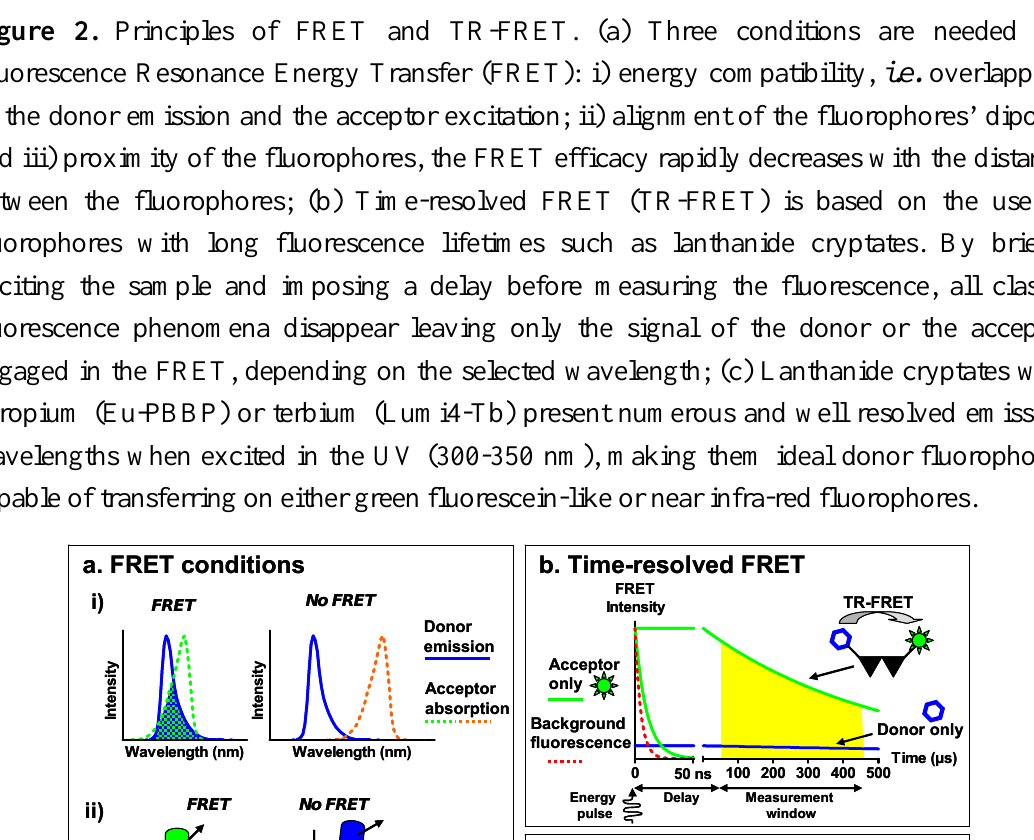
Figure 2. Principles of FRET and TR-FRET. (a) Three conditions are needed for Fluorescence Resonance Energy Transfer (FRET): i) energy compatibility, i.e.